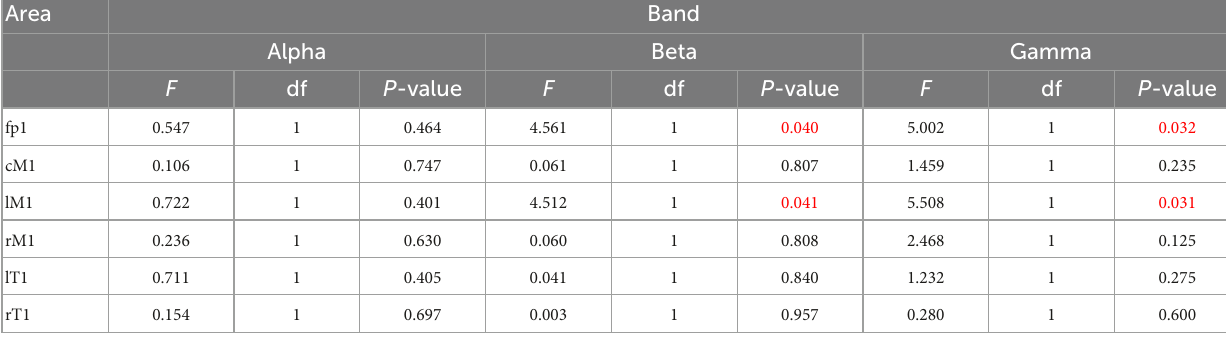
TABLE 1 Statistical analysis of EEG power in different brain regions and frequency bands. Area